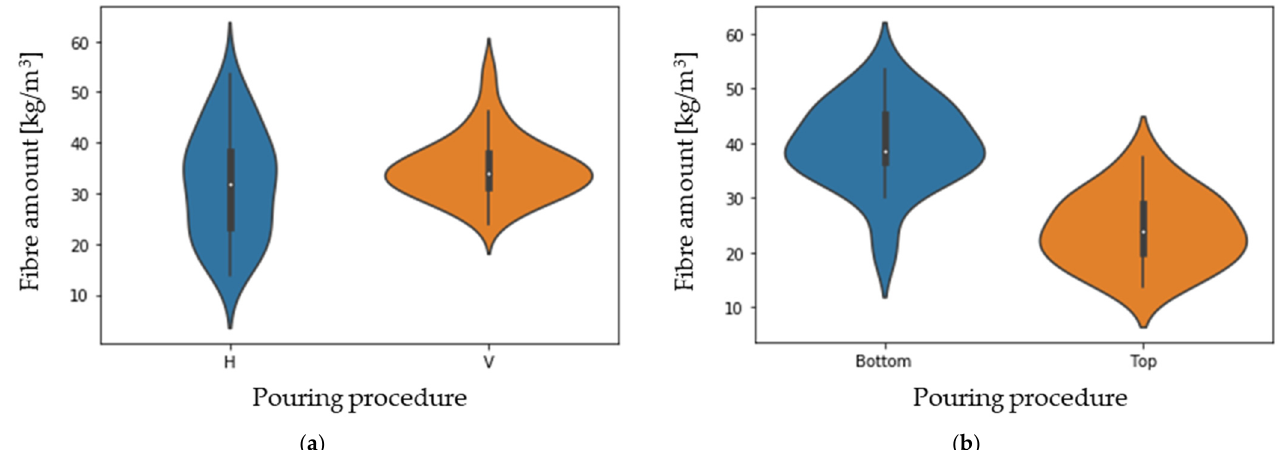
Figure 11. Fibre amount distributions as functions of the pouring procedure ( a ) and of the height for BH ( b ).